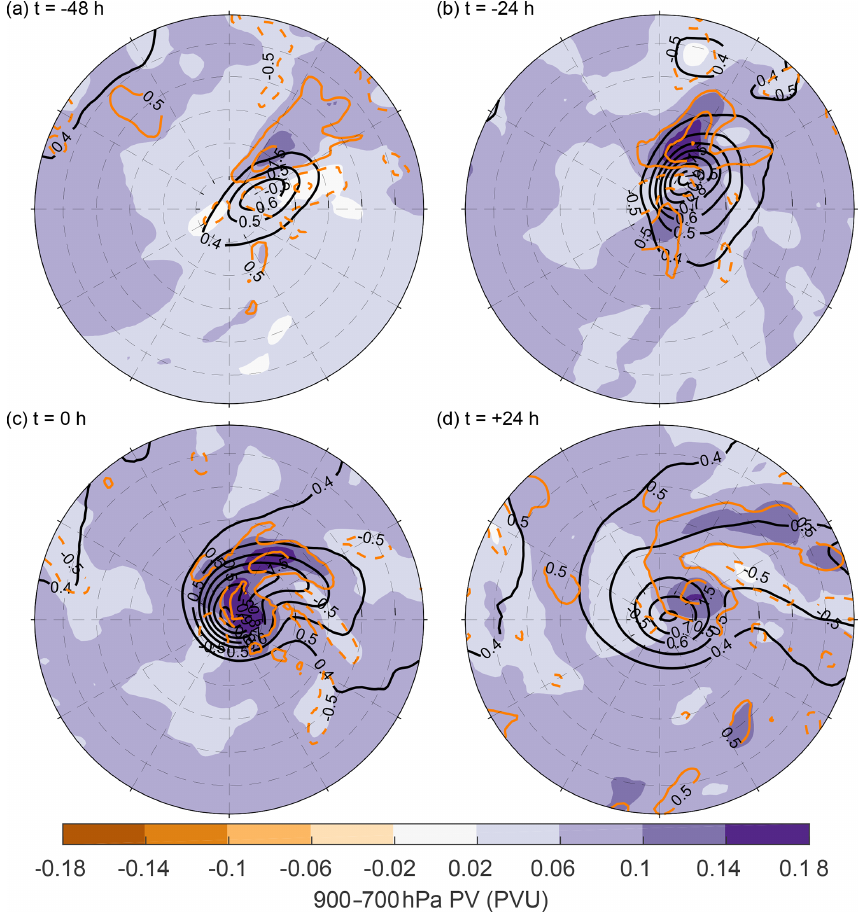
Figure 6. Composite mean of the strongest 200 extra-tropical cyclones at (a) 48h before time of maximum vorticity, (b) 24h before time of maximum vorticity, (c) time of maximum vorticity, and (d) 24h after the time of maximum vorticity. Black contours show the 900–700hPa layer mean potential vorticity in CNTL (contour interval 0.1PVU, starting at 0.4PVU). Shading shows the difference in the 900–700hPa layer mean potential vorticity between SST4 and CNTL. Orange contours show the difference in the 850hPa relative vorticity between SST4 and CNTL (contour interval 0 . 5 × 10 − 5 s − 1 , the 0 contour is omitted). Solid orange contours show positive differences and dashed contours negative